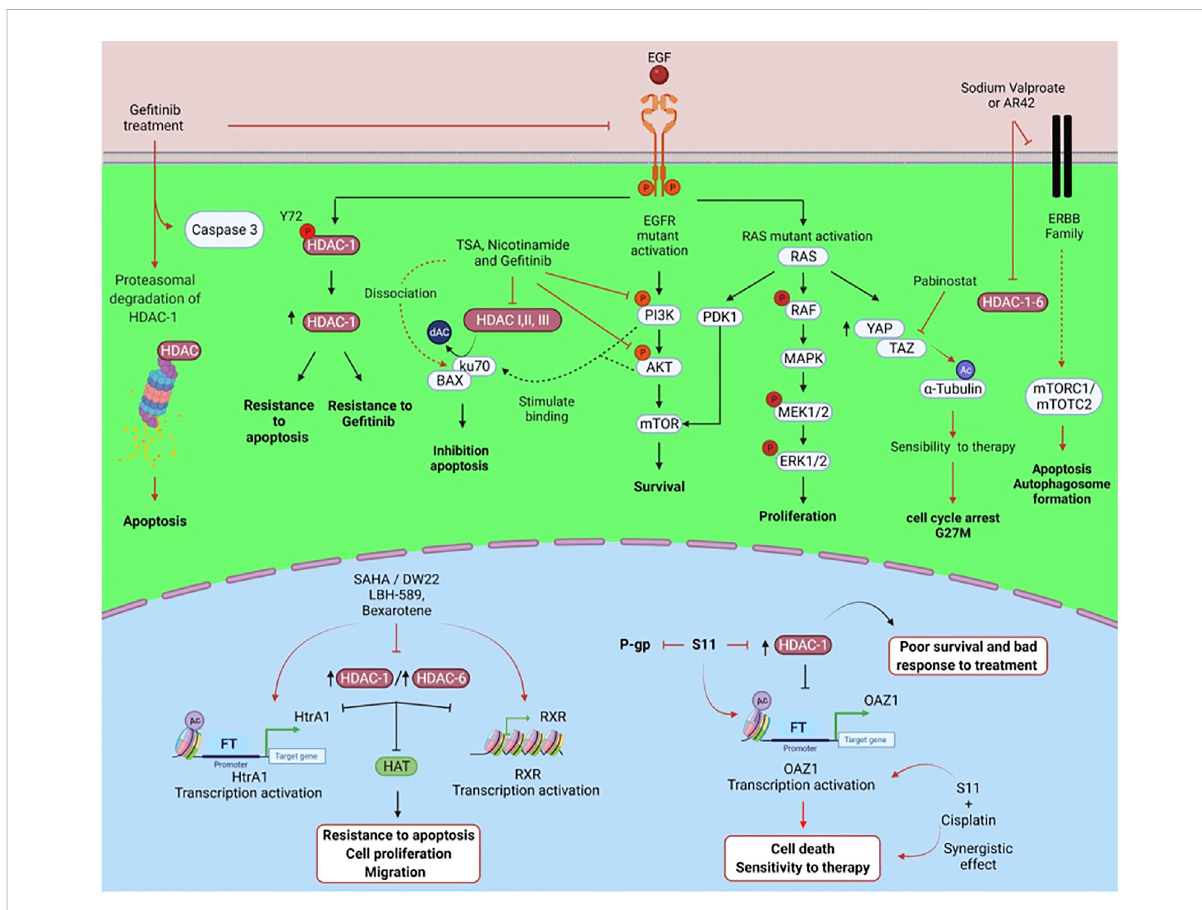
FIGURE 2 Mechanisms of regulation of HDACs and signaling pathways associated with resistance to therapies in lung cancer. Epigenetic therapies with HDAC inhibitors regulate different signaling pathways, proteasome activity, and transcriptional repression of genes involved in the cancer hallmarks of lung cancer. Created with Biorender.com. Phosphorylation Acetylation Up-regulation Activation Inhibition Mechanism promoted by